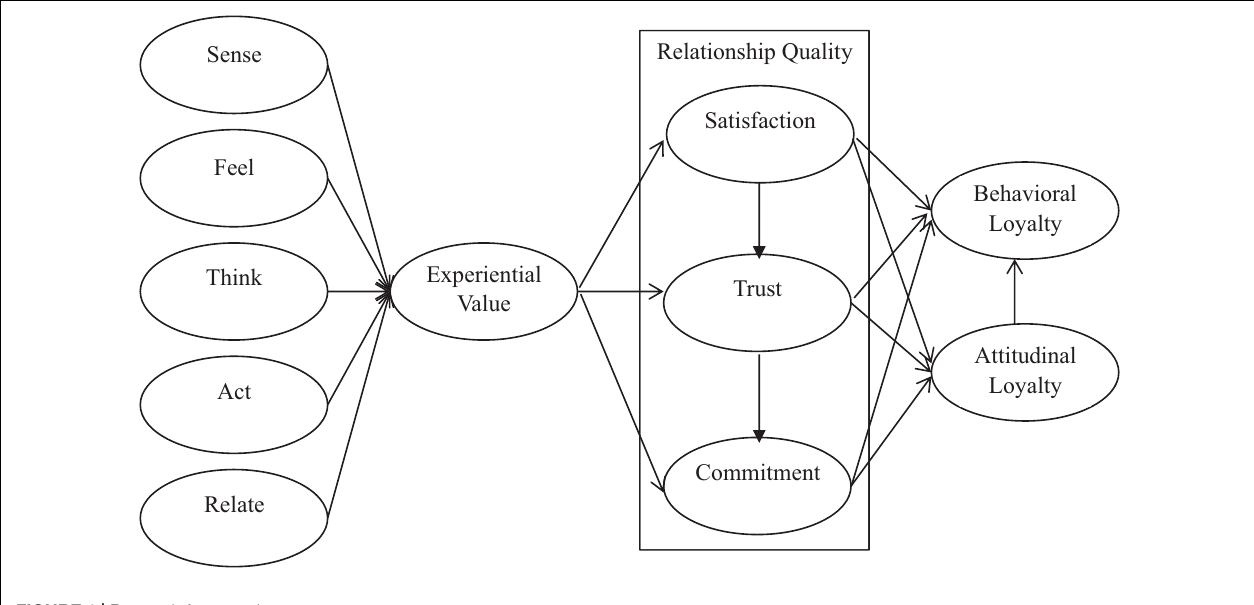
FIGURE 1 | Research